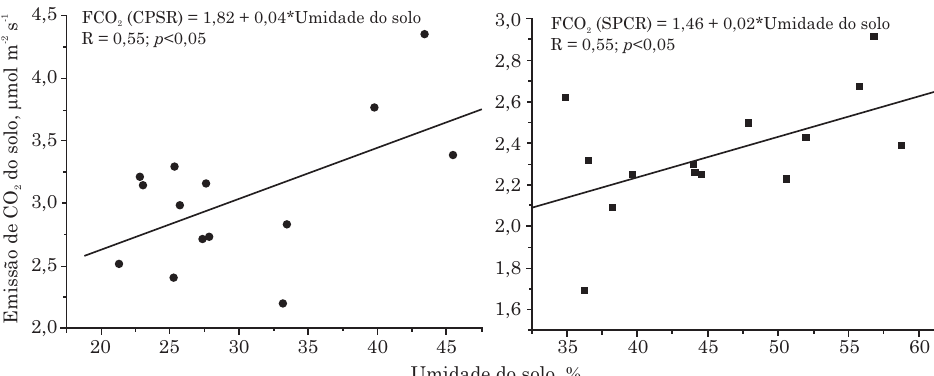
Figura 2. Correlação linear entre emissão de CO 2 e umidade do solo nos manejos: sem preparo e com palha (SPCR) e com preparo e sem palha (CPSR).